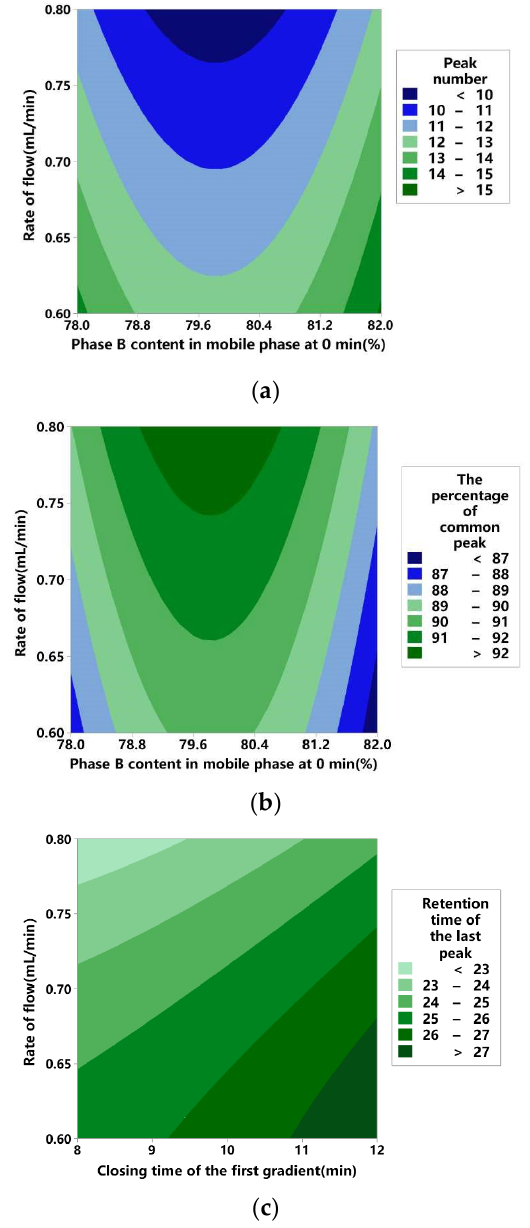
Figure 2. Contour plots of each response variable. In order to better show the relationship between the parameters and the response values, the other parameters are fixed ( a ) Peak number. Closing time of the first gradient was 10 min; closing time of the second gradient was 30 min; column temperature was 28 ° C; ( b ) The percentage of common peak. Closing time of the first gradient was 10 min; column temperature was 28 ° C; ( c ) Retention time of the last peak. Phase B content in mobile phase at 0 min was 80%; phase B content in mobile phase at the beginning of the second gradient was 73%; closing time of the second gradient was 30 min; column temperature was 28 ° C.